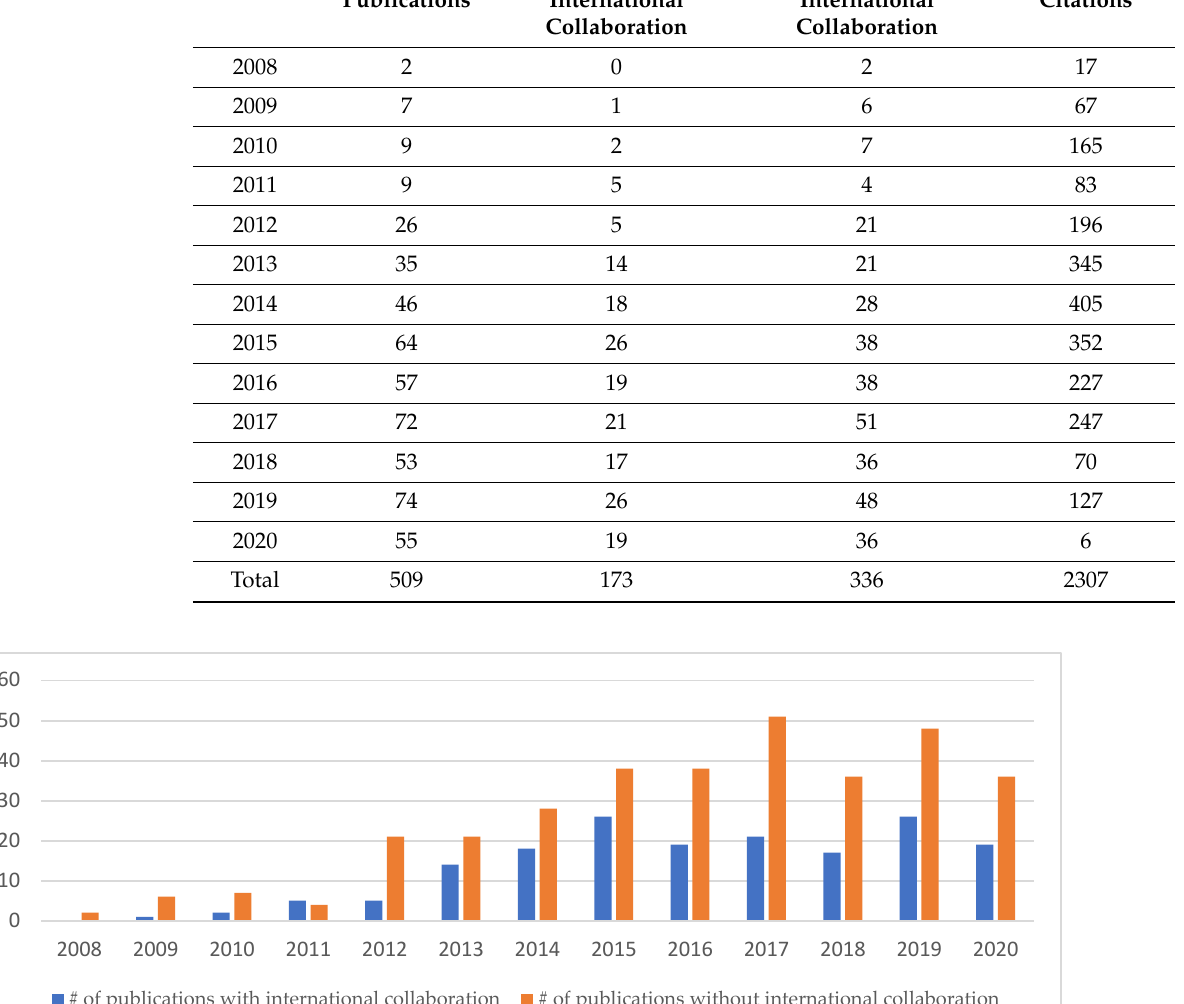
Figure 2. Total numbers of publications and citations from 2008 to 2020. Figure 3. Co-authorship network, https://github.com/Aalabduljabbar/CSE-Publications (accessed on 1 February 2022). The density of the network is based on the percentage of links compared with the total possible links in the network. The degree of density of the co-authorship network